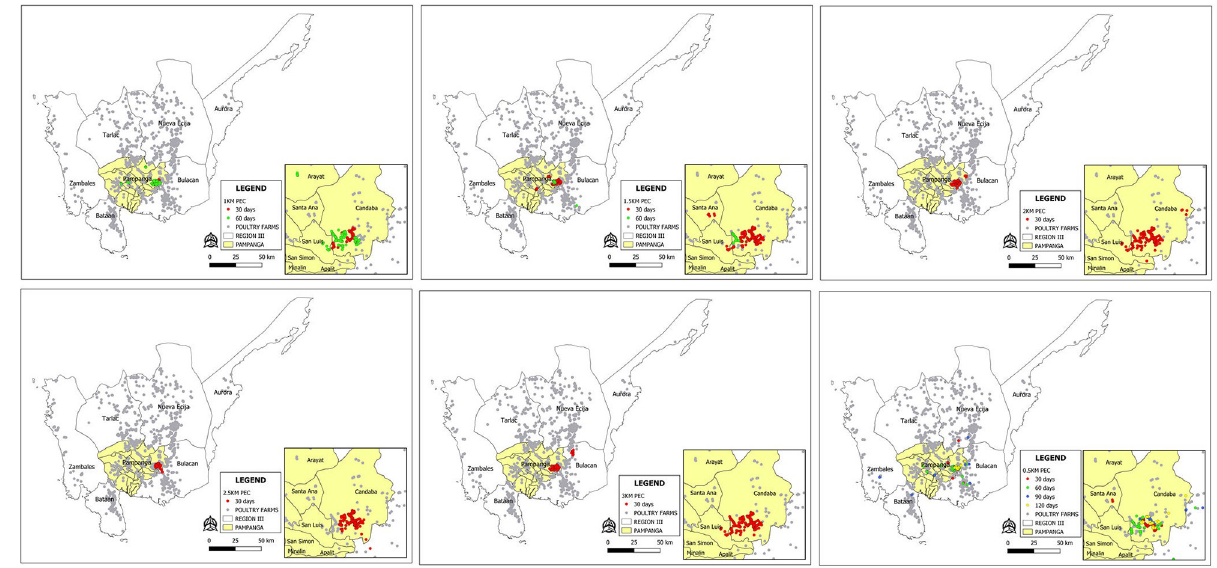
Fig 2. Comparison of the spatio-temporal progression of HPAI epidemic managed with pre-emptive culling at various radius from infected farms. Colored dots represent the totality of infected and pre-emptively culled farms according to the duration of the epidemic.